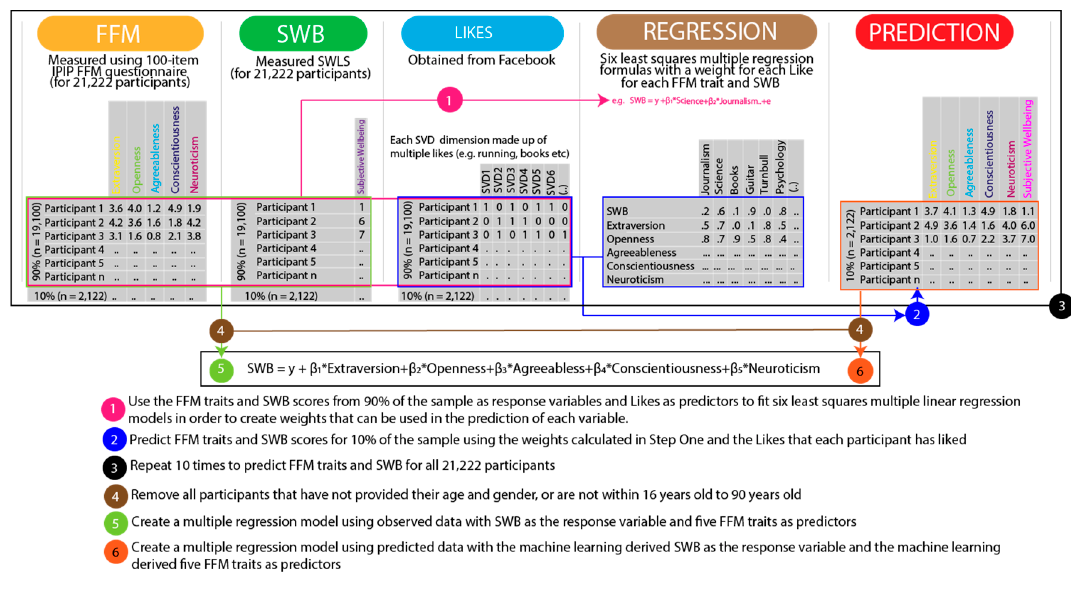
Figure 1. A graphical representation of the research design.